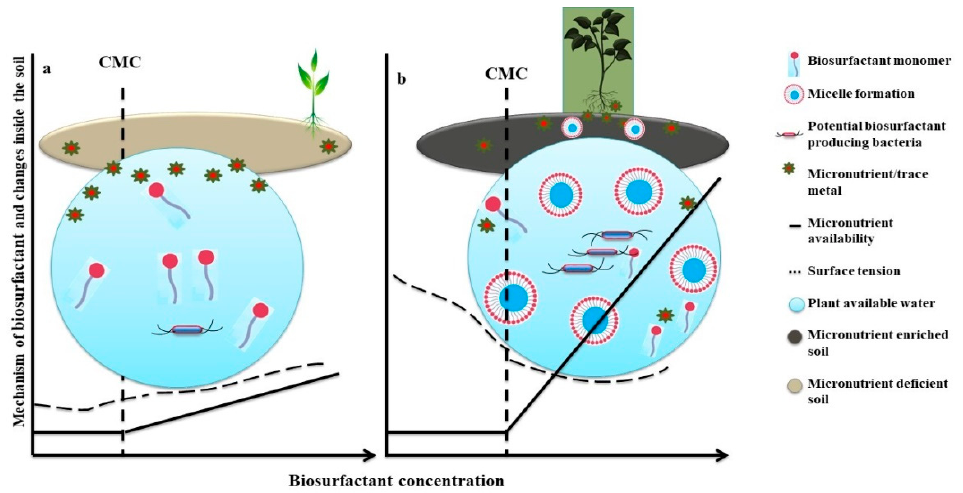
Figure 3. Impact of micronutrient deficiency on plant growth and soil quality on a micronutrient- deficient soil. ( a ) Mechanisms of biosurfactant application enhancing micronutrient availability in micronutrient-deficient soil to the plant, soil quality, and related water quality through increasing nutrient solubility at a fixed concentration of biosurfactant molecule. ( b ) C.M.C. at which there is a sudden increase in metal solubility in the system. Figures are adapted and modified from Mulligan [13] and Singh et al. [114].